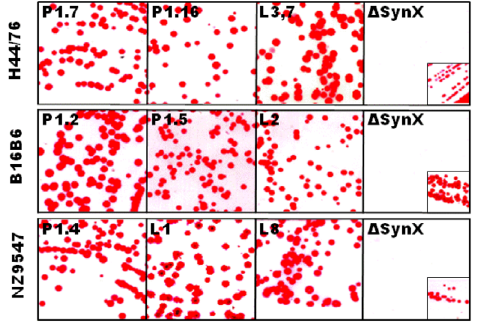
Figure 1. Capsule, LOS and PorA expression by the Vaccine Strains used to make the NOMV. Colony blots of the vaccine strains with monoclonal antibodies specific for the LOS and PorA antigenic epitopes. The monoclonal antibodies used to detect the capsule, PorA and LOS are described in Materials and Methods. The insert in each of the capsular frame shows the result with a positive control.